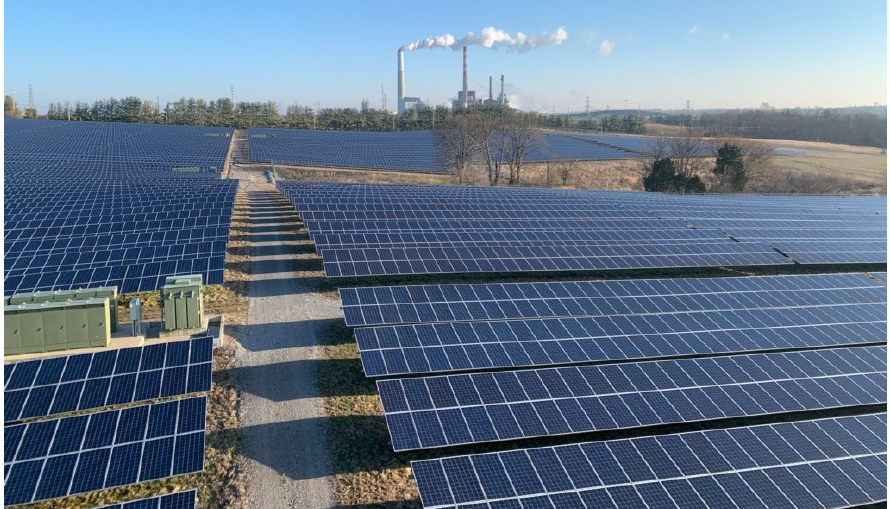
Figure 1. The aerial view of the E.W. Brown generating station, which includes Kentucky’s largest solar farm, hydropower plant, natural gas units, and coal fired power